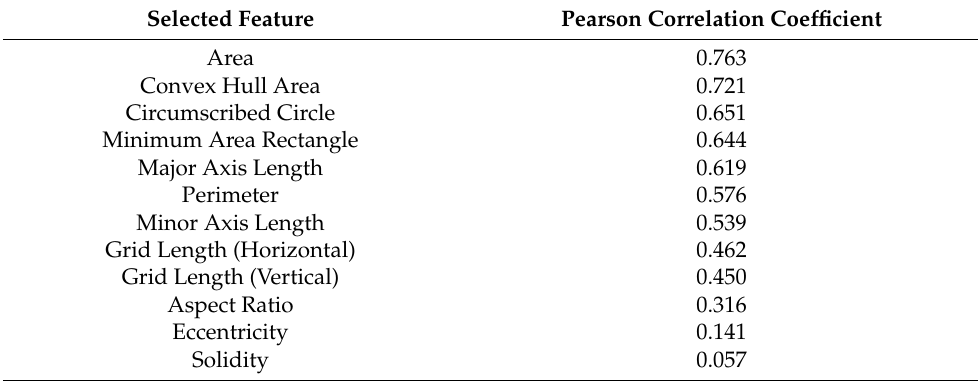
Table 3. Features selected for the WSS method and their correlation coefficients.